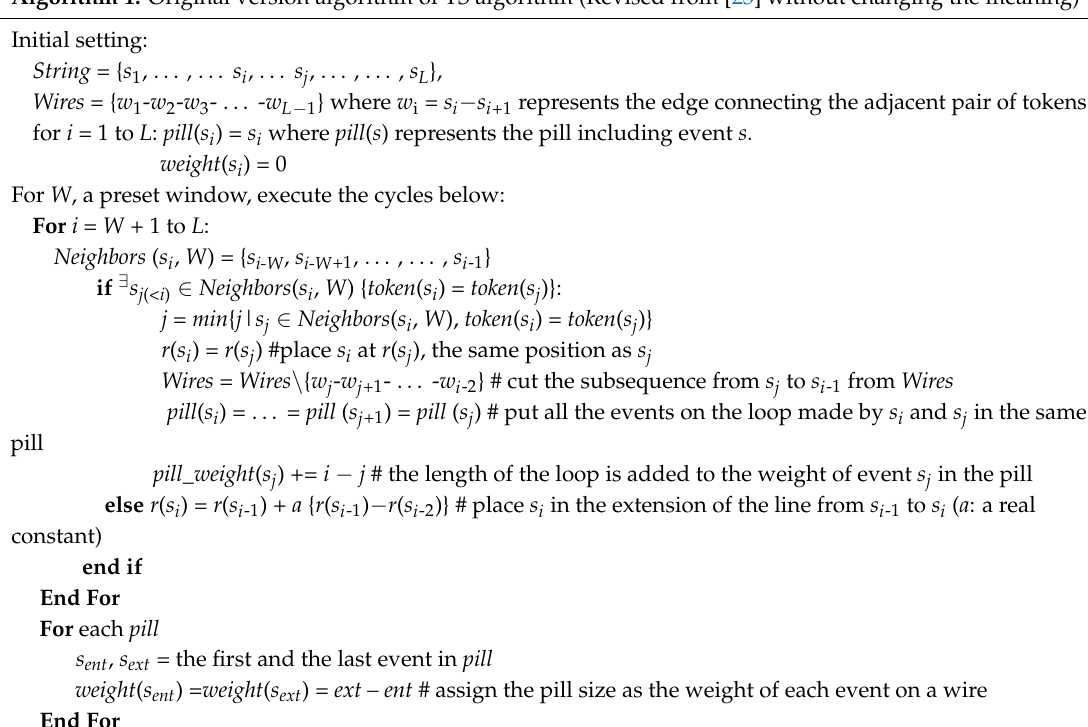
Algorithm 1. Original version algorithm of TS algorithm (Revised from [23] without changing the